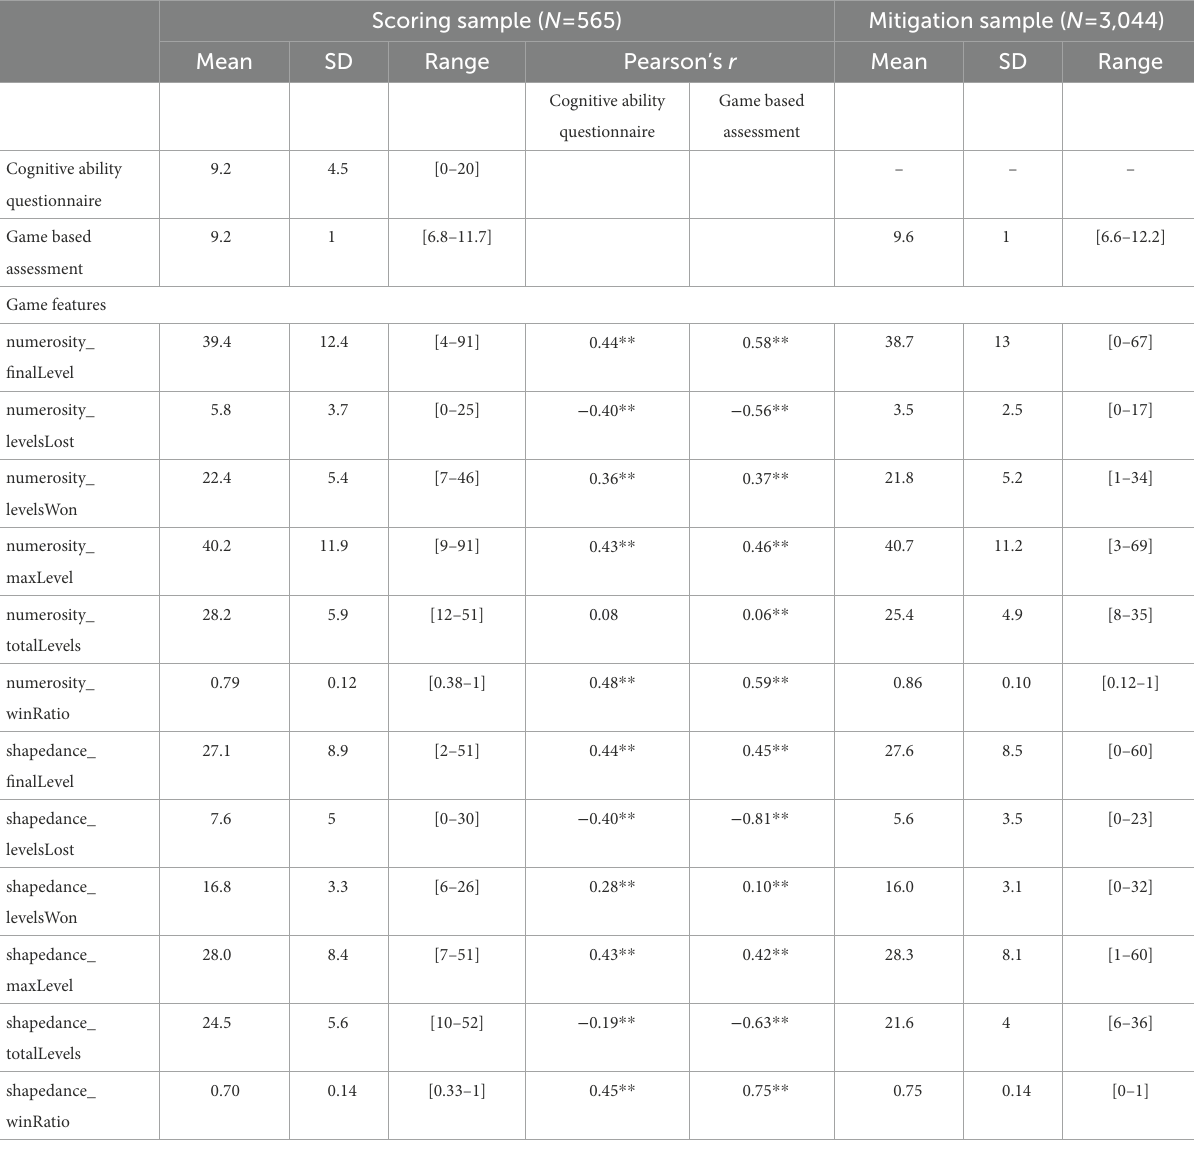
TABLE 3 Descriptive statistics for the cognitive ability questionnaire, cognitive game based assessment, and cognitive ability games features in the scoring and validation samples as well as correlations between game behaviour and cognitive ability